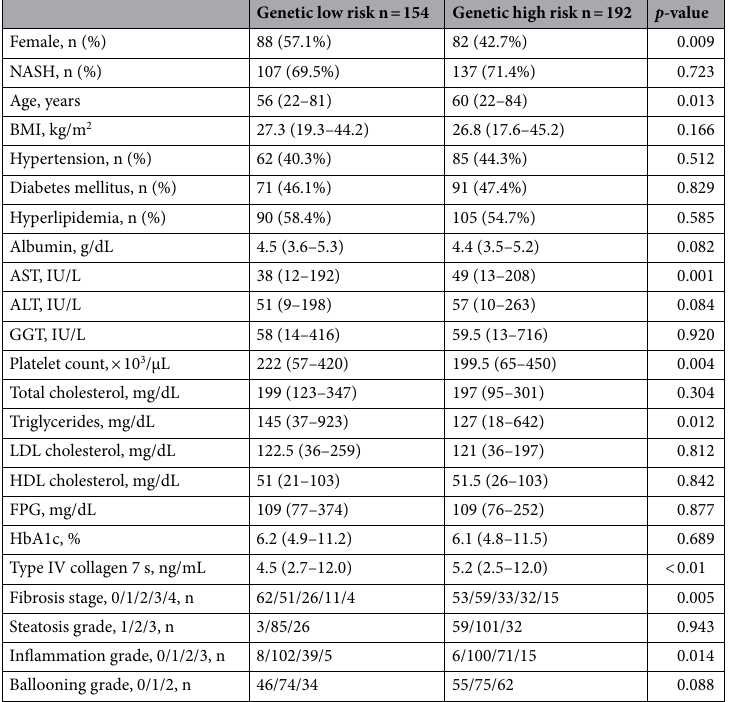
Table 2. Patient characteristics by genetic risk. BMI body mass index, AST aspartate aminotransferase, ALT alanine aminotransferase, GGT gamma-glutamyl transferase, LDL low-density lipoprotein, HDL high-density lipoprotein, FPG fasting plasma glucose.